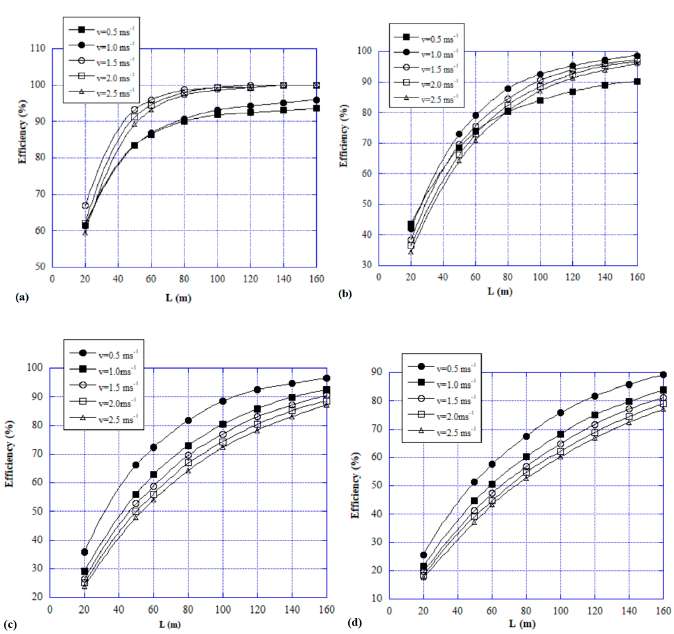
Figure 9. Efficiency of the EAHX operating in cooling mode vs length, parametrized for air velocity with: ( a ) D = 0.1 m; ( b ) D = 0.2 m; ( c ) D = 0.3 m; ( d ) D = 0.4 m.